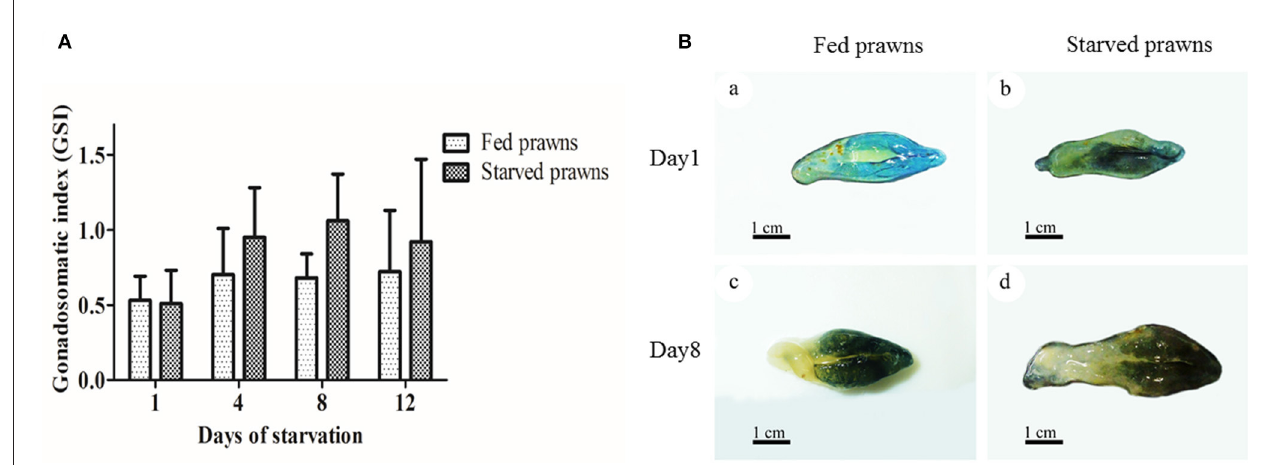
FIGURE 1 | Effect of starvation on gonado-somatic index (GSI) and ovarian size. (A) Mean gonadosomatic index (GSI) of the starved prawns determined at days 1, 4, 8, and 12 compared to that of the fed prawns. (B) Gross morphology and sizes of the ovaries from fed and starved prawns at days1 and 8. Bar 1cm (a–d) ( n =